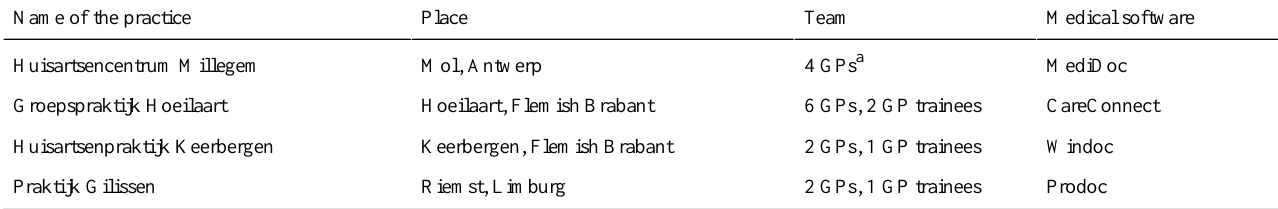
Table 1. Overview of recruiting